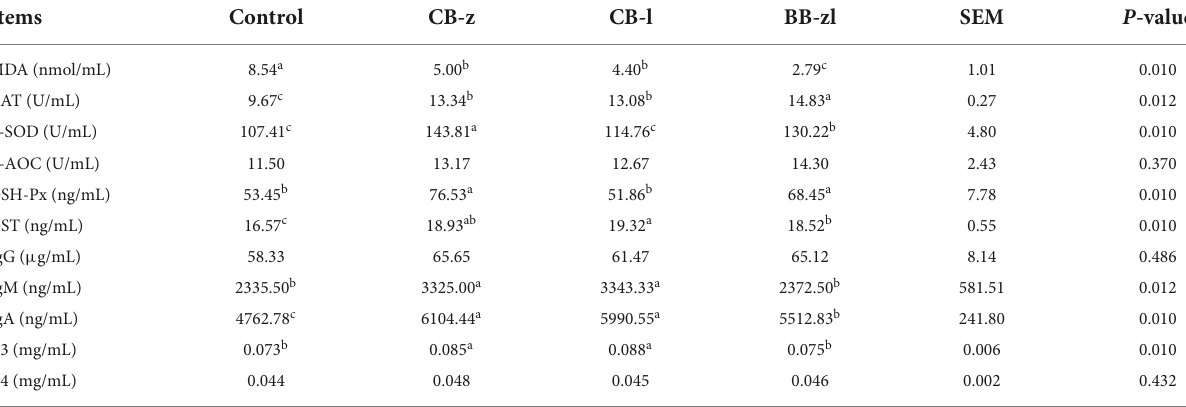
TABLE 5 Effects of Clostridium butyricum and Brevibacillus sp. on the serum antioxidant and immune capacity of laying hens.